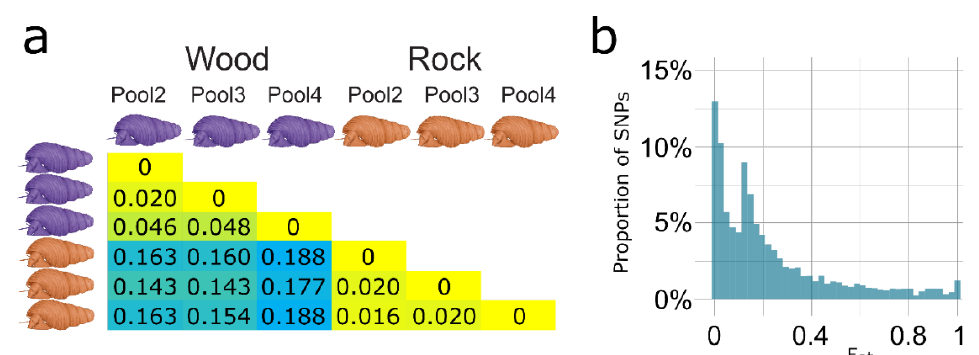
Figure 3. Evolutionary divergence of T. sarasinorum ecomorphs. ( a ) Depiction of median SNP-wise F st , for pairwise comparisons of pools of both ecomorphs. The degree of differentiation from low to high is indicated by color change from yellow to blue. ( b ) Distribution of SNP-wise F st between ecomorphs for 517,852 putative SNPs (60× minimum coverage (20× per pool), 10% MAF, all pools of each ecomorph combined). Although some SNPs exhibit high differentiation, the majority of variation is shared among both ecomorphs.